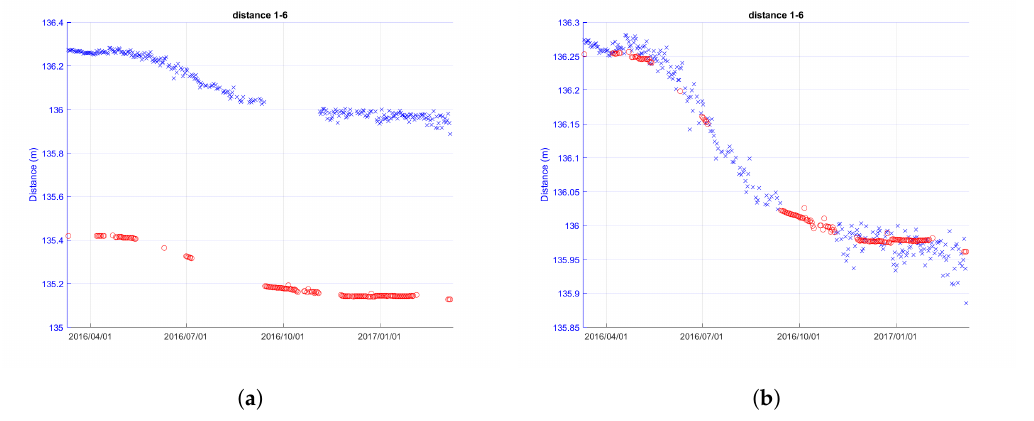
Figure 9. Comparison between the Wi-GIM UWB (blue crosses) and the RTS (red circles) systems to measure the distance between node 1 and 6 (Cluster 1—Roncovetro). ( a ) Data averaged over one day without offset compensation; ( b ) Data averaged over one day with offset compensation.